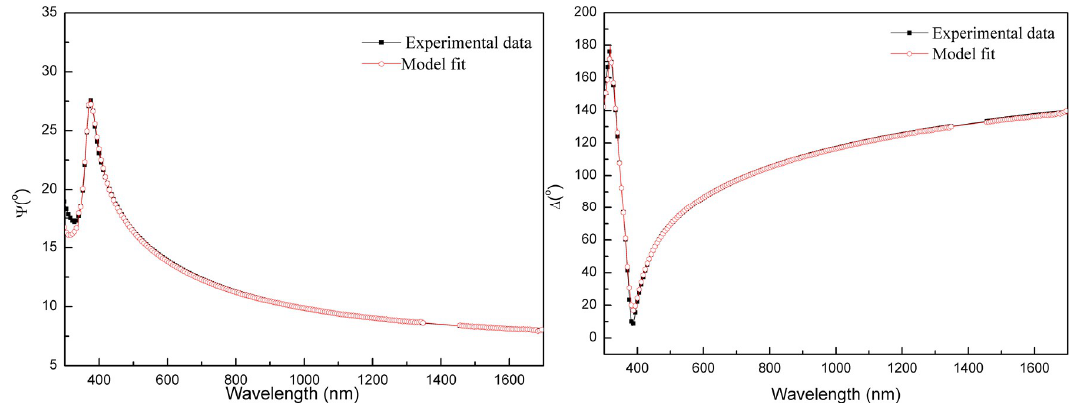
Figure 1. Experimental data for a TiO 2 thin film deposited at Ar:O 2 flow rate of 30:1.5 sccm vs. the model fit with a single Gauss oscillator for ( a ) the amplitude ratio Ψ , and ( b ) the phase di ff erence ∆ .